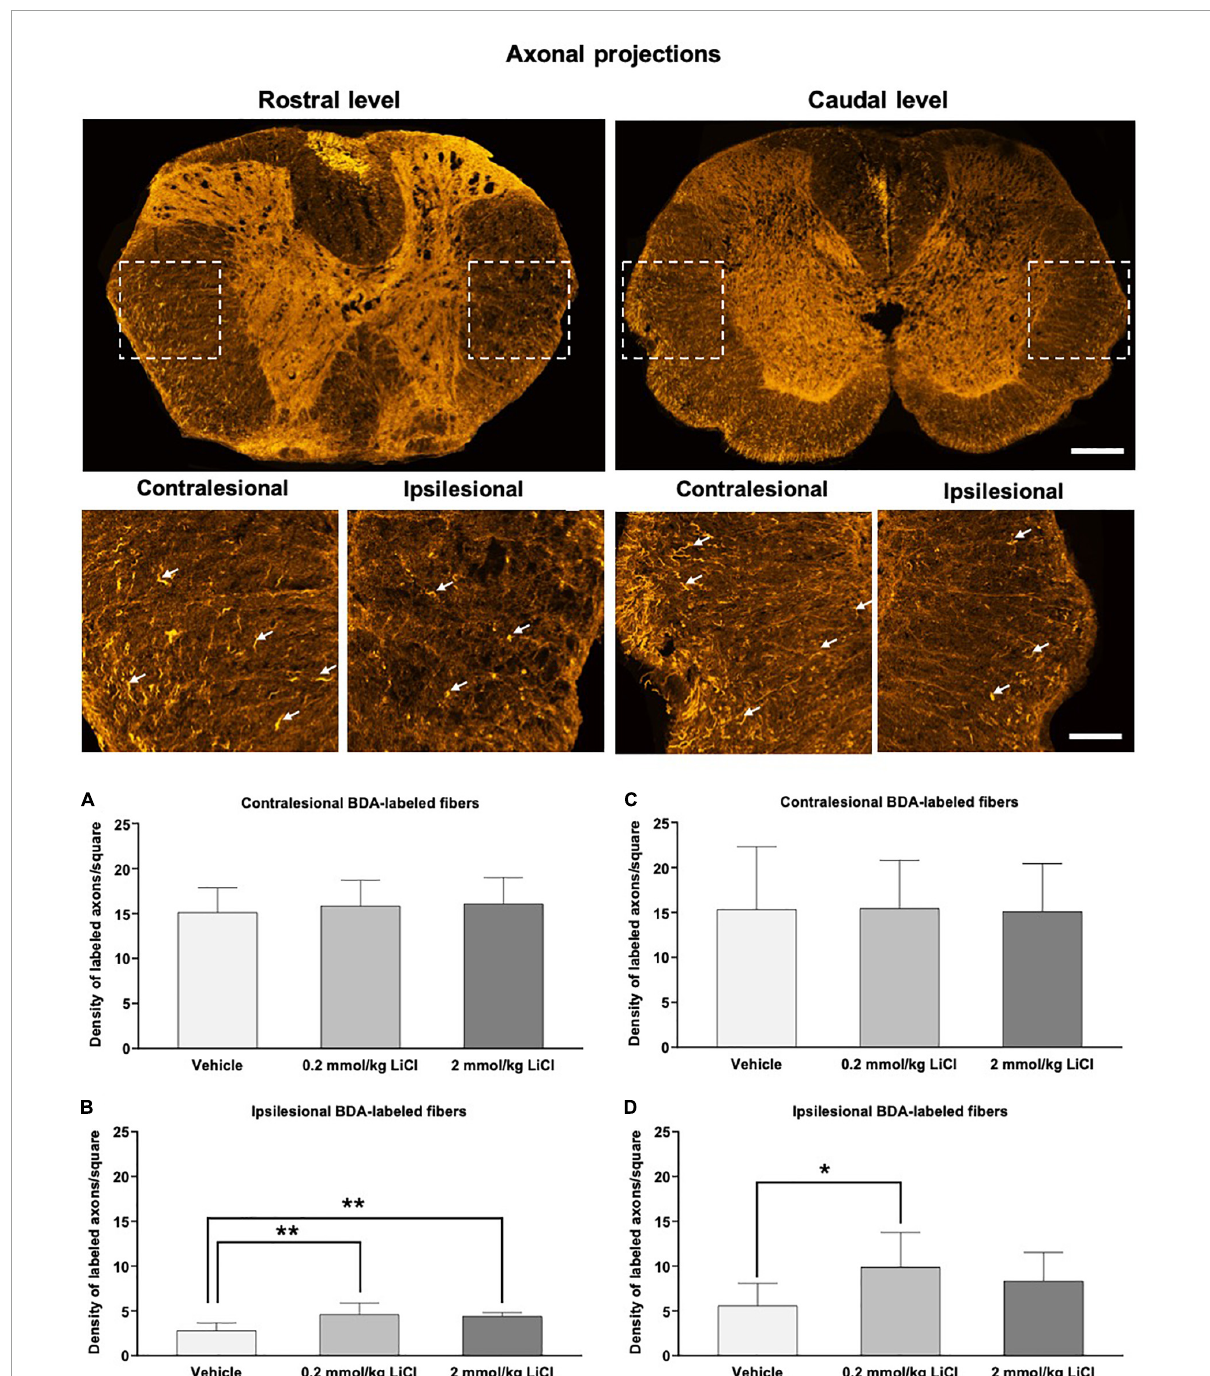
FIGURE6 Low-dose and high-dose lithium enhances axonal regeneration proximal and distal to the hemitransection. Representative confocal microscopy images with enlargements of BDA-stained fibers ascending through the injured spinal cord at the rostrocaudal levels above the hemitransection (“Rostral level”) and below the hemitransection (“Caudal level”) of an SCI mouse treated with vehicle, in which BDA had bilaterally been injected into the spinal cord at the L2 level. Quantitative analysis of the density of BDA-labeled fibers in (A,C) the contralesional lateral spinothalamic tract and (B,D) the ipsilesional lateral spinothalamic tract at (A,B) at the rostrocaudal level rostral to the hemitransection (“Rostral level”) and (C,D) the rostrocaudal level caudal to the hemitransection (“Caudal level”) of SCI mice, which were treated with vehicle or lithium (0.2 or 2 mmol/kg/day) for 56 days. Data are mean ± SD values ( n = 16 animals/group). * p < 0.05/** p < 0.01 for 0.2 mmol/kg or 2 mmol/kg LiCl vs. vehicle. Please note that white arrows indicate representative BDA-labeled fibers. Scale bars, 200 µ m (lower magnification images)/50 µ m (higher magnification